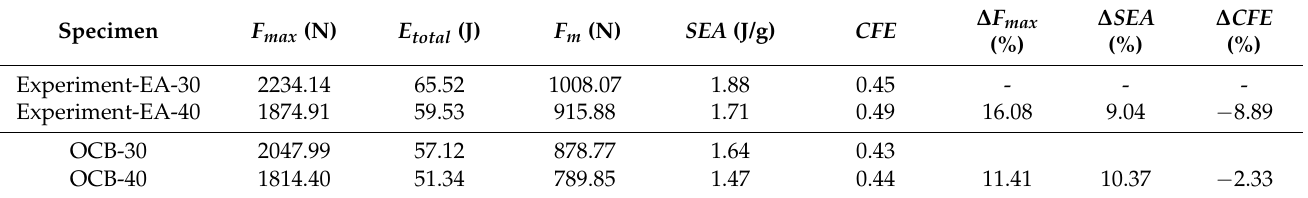
Table 6. Experimental and simulated energy absorption indexes at different temperatures.